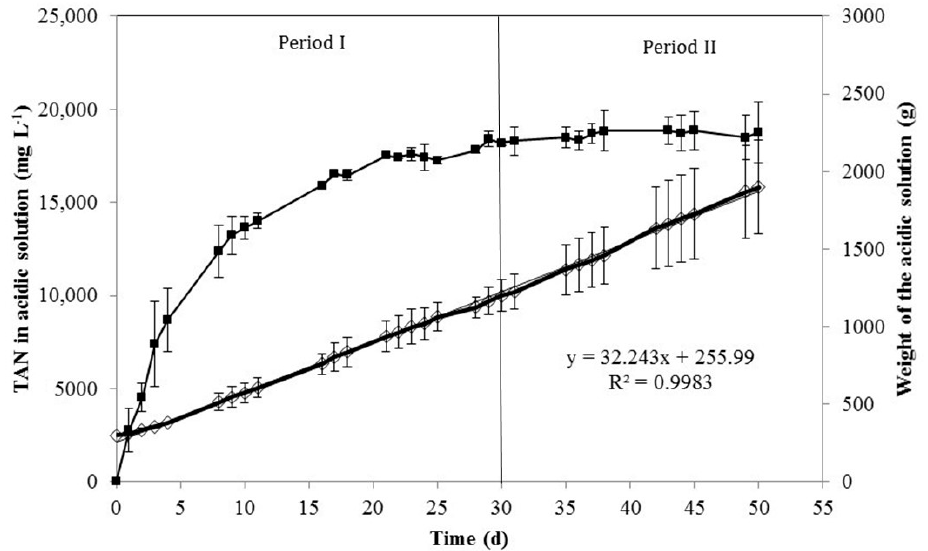
) during the (cid:51)